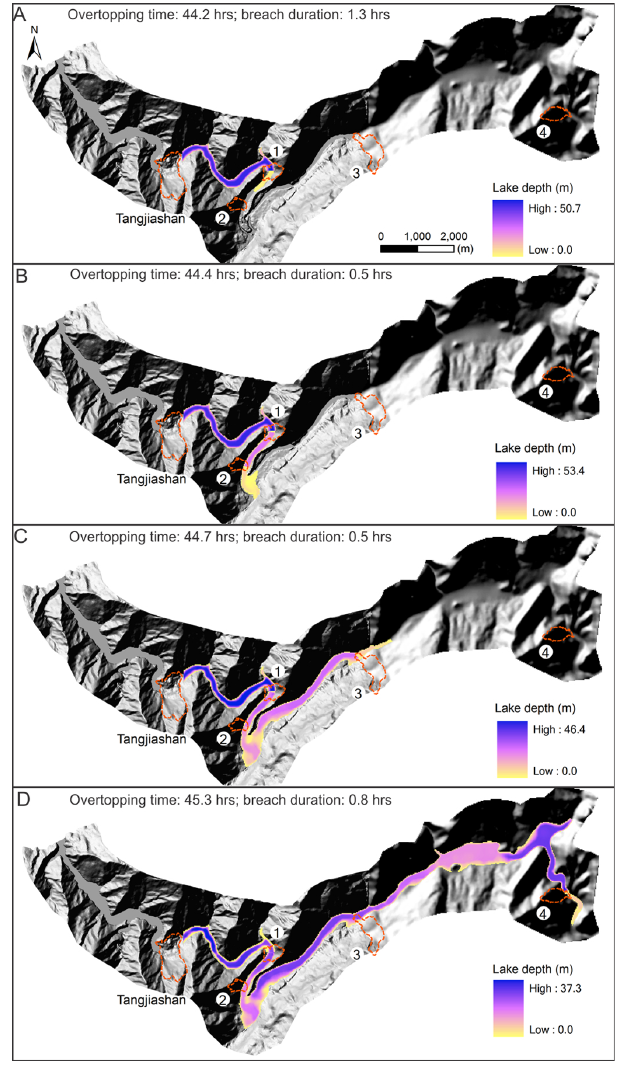
Fig. 12. Cascading breach of dam 1–4 (A–D) at the downstream part of the Tangjiashan dam.